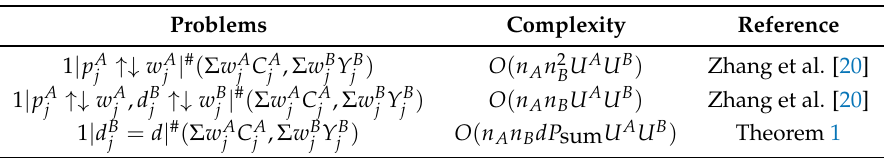
Table 1. Complexity of three